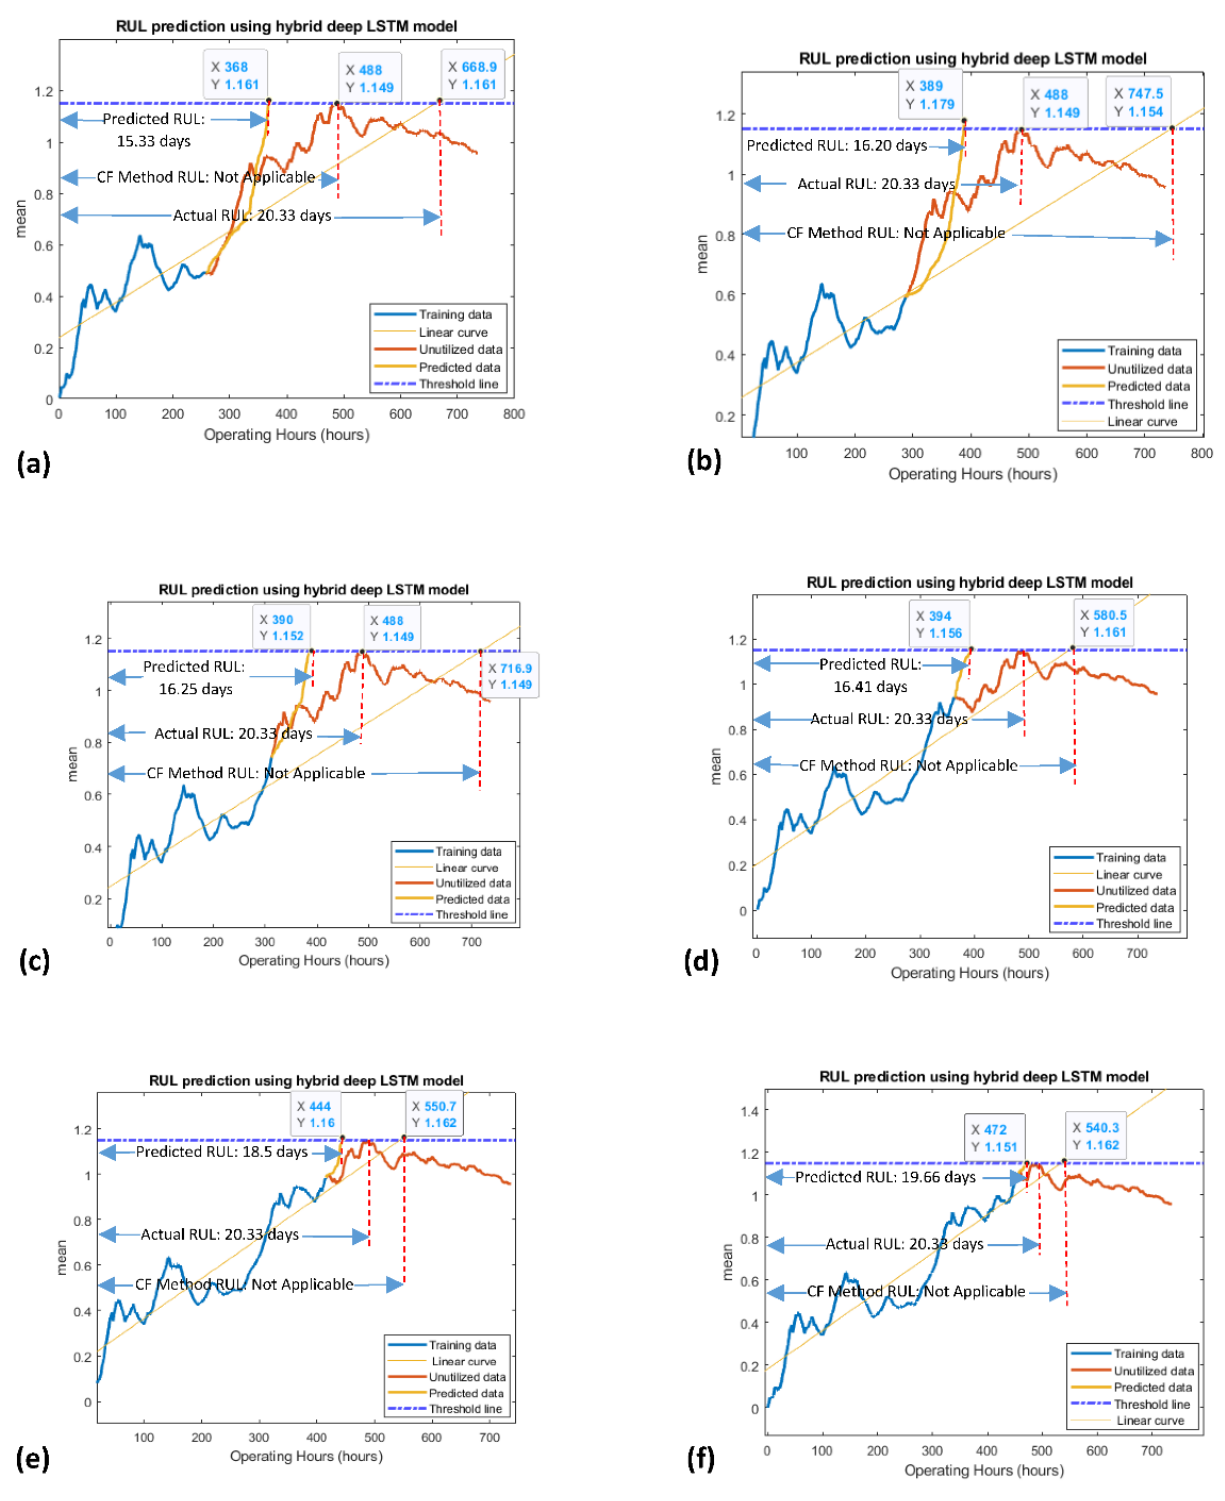
Figure 8. Online RUL prediction results obtained by the curve-fitting and proposed methods for channel 2, ( a – f